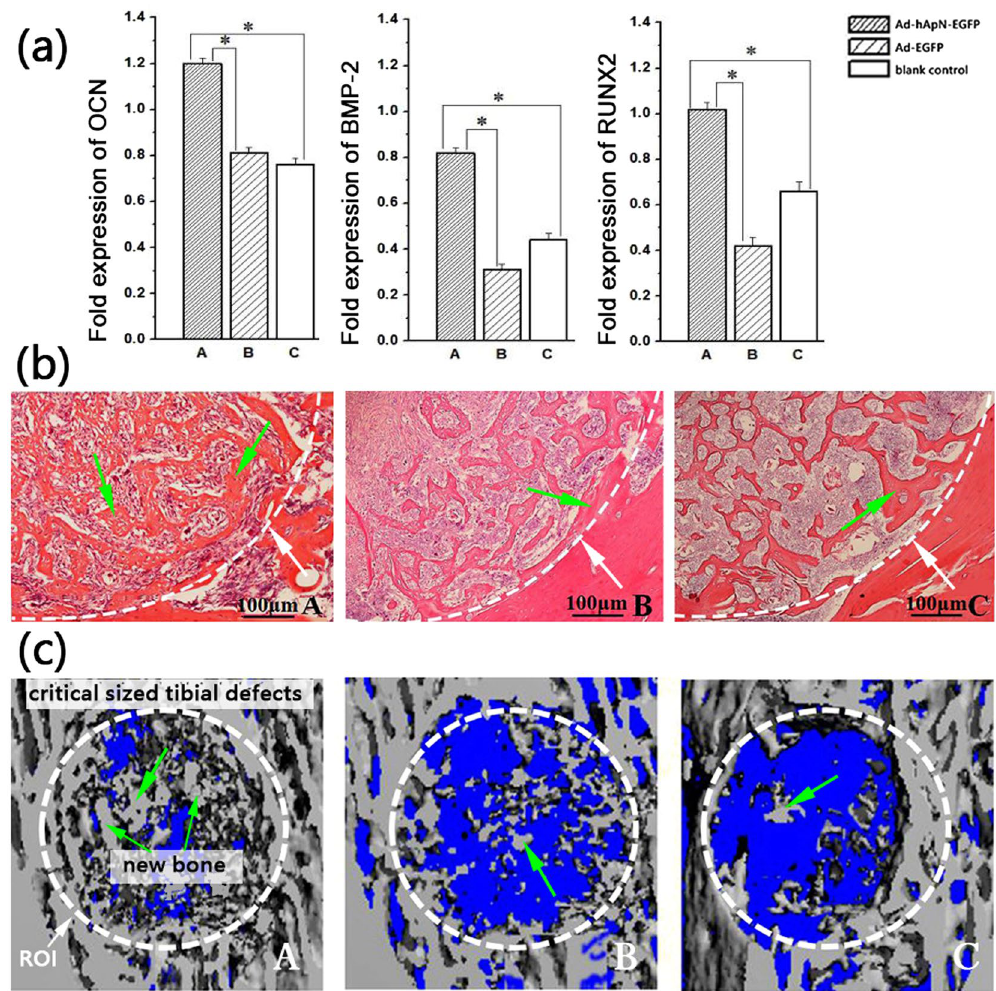
Figure 10. Osteogenesis detection in bone defect areas. ( a ) The expression of osteogenesis related genes on the 7th postoperative day, including OCN, BMP-2 and RUNX2. These three genes were significantly increased in group A compared with the other two groups. * P < 0.05; ( b ) Haematoxylin and eosin staining of bone defect areas on the 7th postoperative day. The white arrow indicated the bone defect edge. More new trabecular bone (green arrow) in group A; ( c ) Three-dimensional micro-CT images of bone defect areas. The white line dotted the region of interest area. More new bone (green arrow) were found in group A.